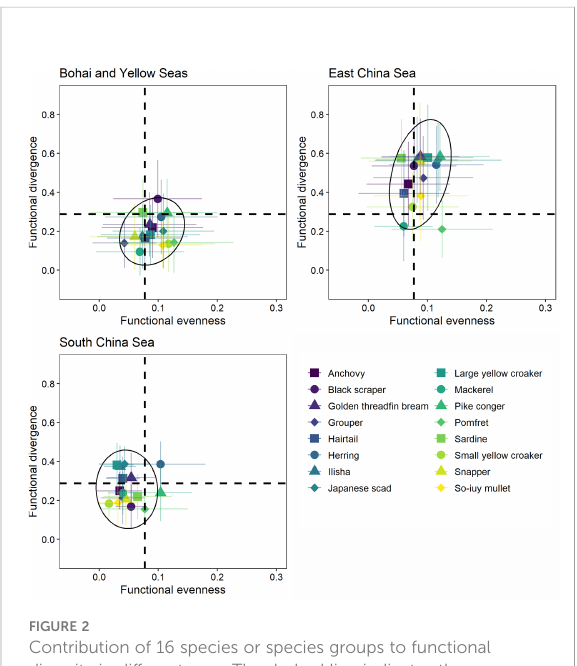
FIGURE 2 Contribution of 16 species or species groups to functional diversity in different seas. The dashed line indicates the average contribution of all species across three seas. The black circle is 95% con fi dence level ellipse for a multivariate t-distribution.